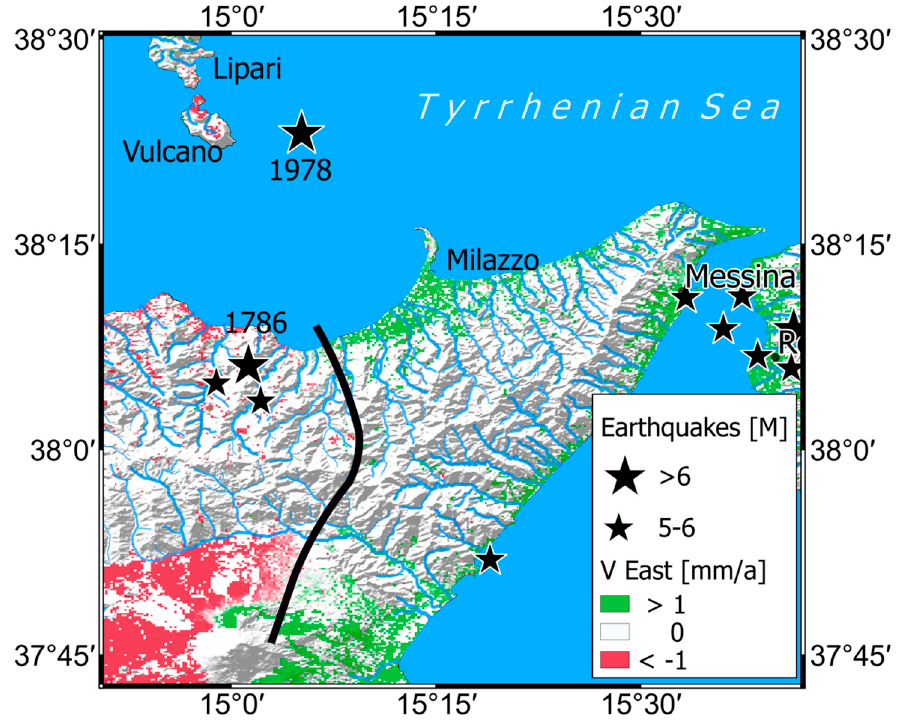
Figure 12. East component of velocity field in Eastern Sicily and main historical earthquakes occurred since